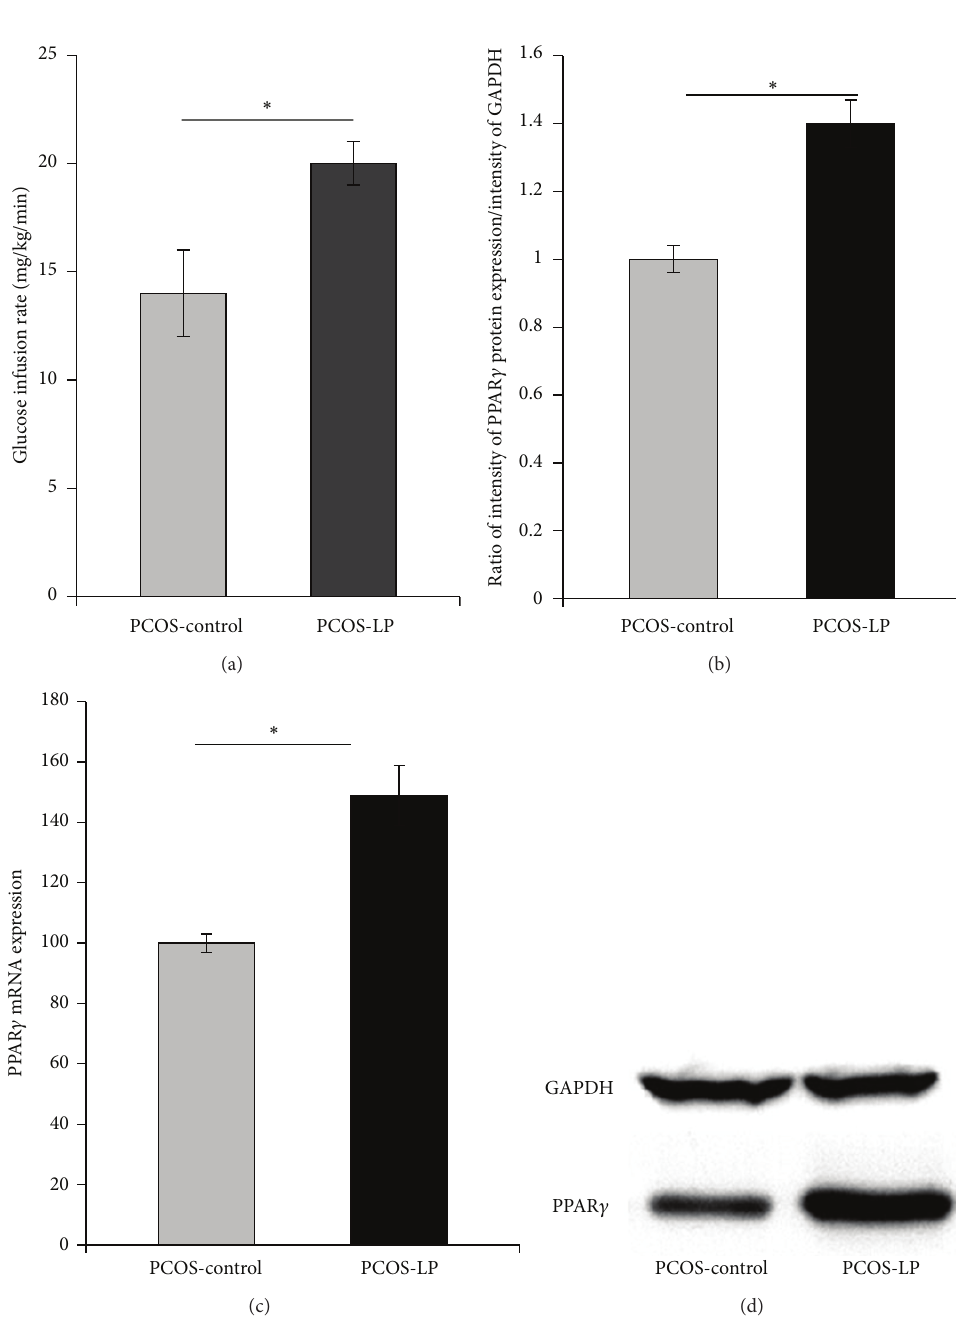
Figure 1: (a) Glucose infusion rate, at steady state, required to maintain euglycemia during euglycemic-hyperinsulinemic clamp in PCOS LPva rats and PCOScontrols. Values are mean ± SEM,PCOS LPversus PCOS-control, ∗ 𝑃 < 0.05 (theMann-Whitney 𝑈 test).(b) Quantitative blot of PPARgamma protein in PCOS rat adipose tissues. (c) Relative PPARgamma mRNA expression in the adipose tissue of PCOS control ( 𝑛 = 8 ) versus PCOS LP ( 𝑛 = 10 ). The mRNA was corrected by 𝛽 -actin. The level of the expression in the control group was arbitrarily set at 100%. (d) Representative Western blot of PPARgamma in PCOS rat adipose tissues. Western blots of total protein were probed with anti-PPARgamma antibodies and then reprobed with anti-GAPDH to confirm equal loading. Densitometric analyses presented as the relative ratio of PPARgamma to GAPDH. The results represent mean ± S.E.M. from 3 independent experiments. ∗ 𝑃 < 0.05 as determined by the Mann-Whitney 𝑈